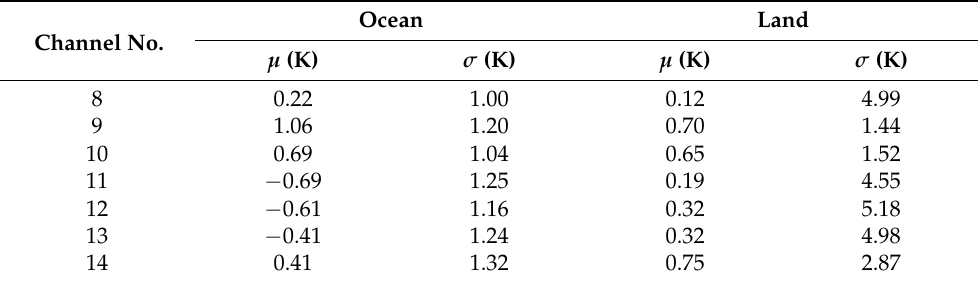
Table 3. Biases and standard deviations calculated by the differences in brightness temperature between AGRI observations and ARMS simulations using the FNL dataset as the background for data under clear–sky conditions and with satellite zenith angles less than 60 ◦ in January, April, July, and October 2019. Ocean Channel No.